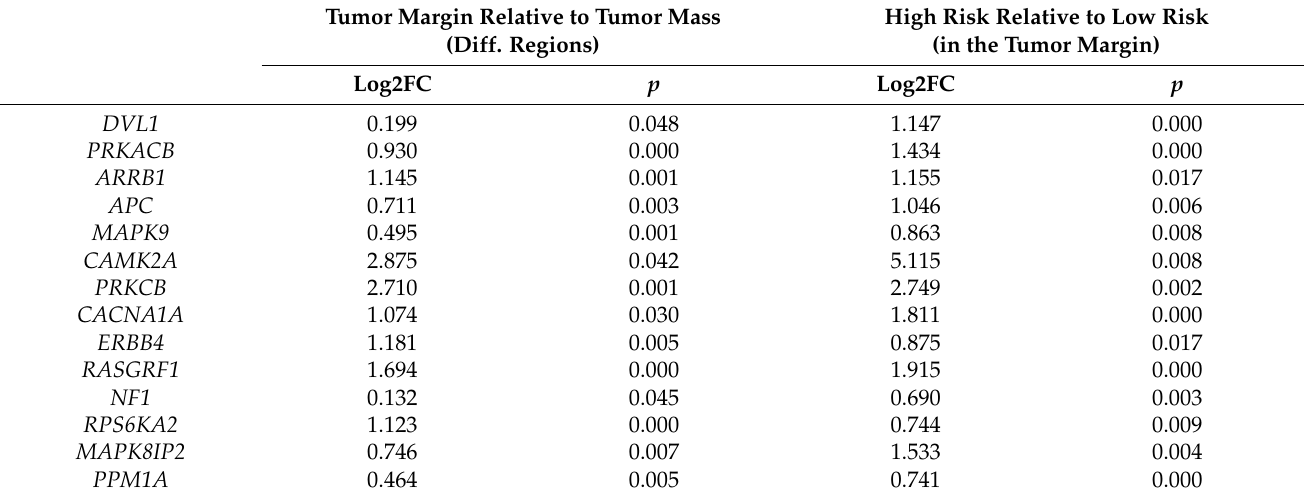
Table 2. Expression fold change of GBM recurrence-associated biomarkers between regions and risk groups. Tumor Margin Relative to Tumor Mass